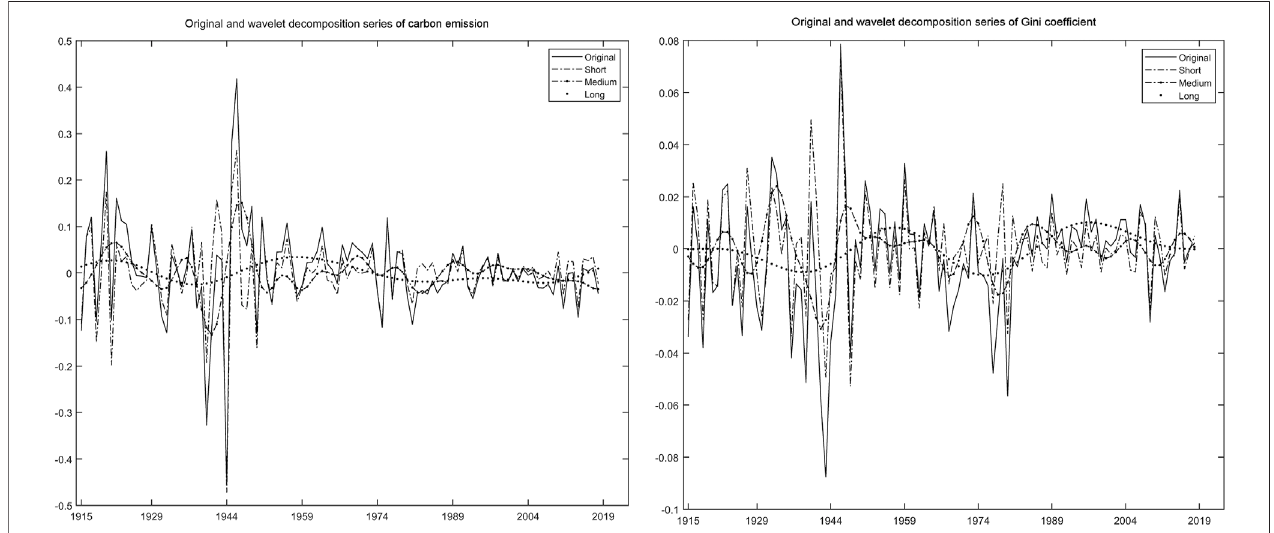
FIGURE 1 | Original and wavelet decomposition series of carbon emission and Gini coef fi cient for France.